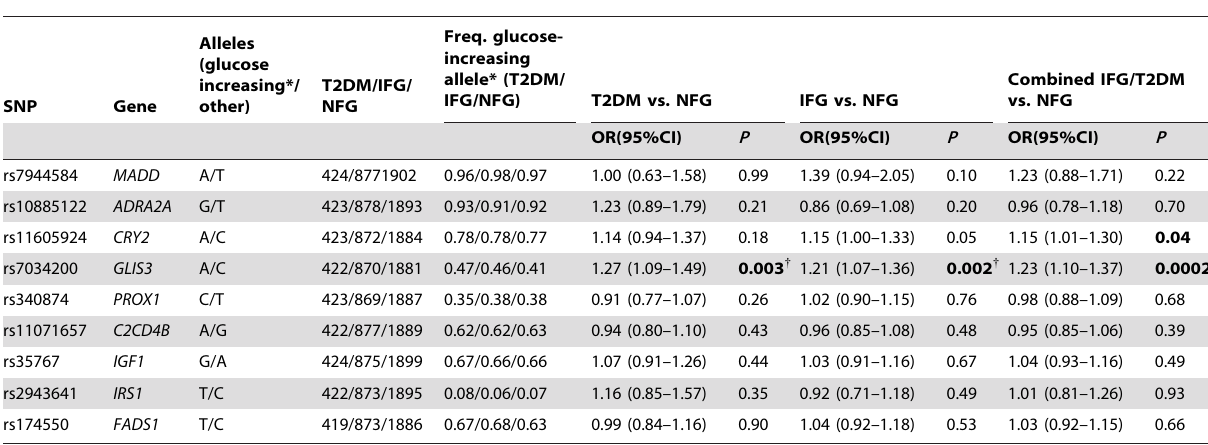
Table 3. Associations with type 2 diabetes and combined IFG/type 2